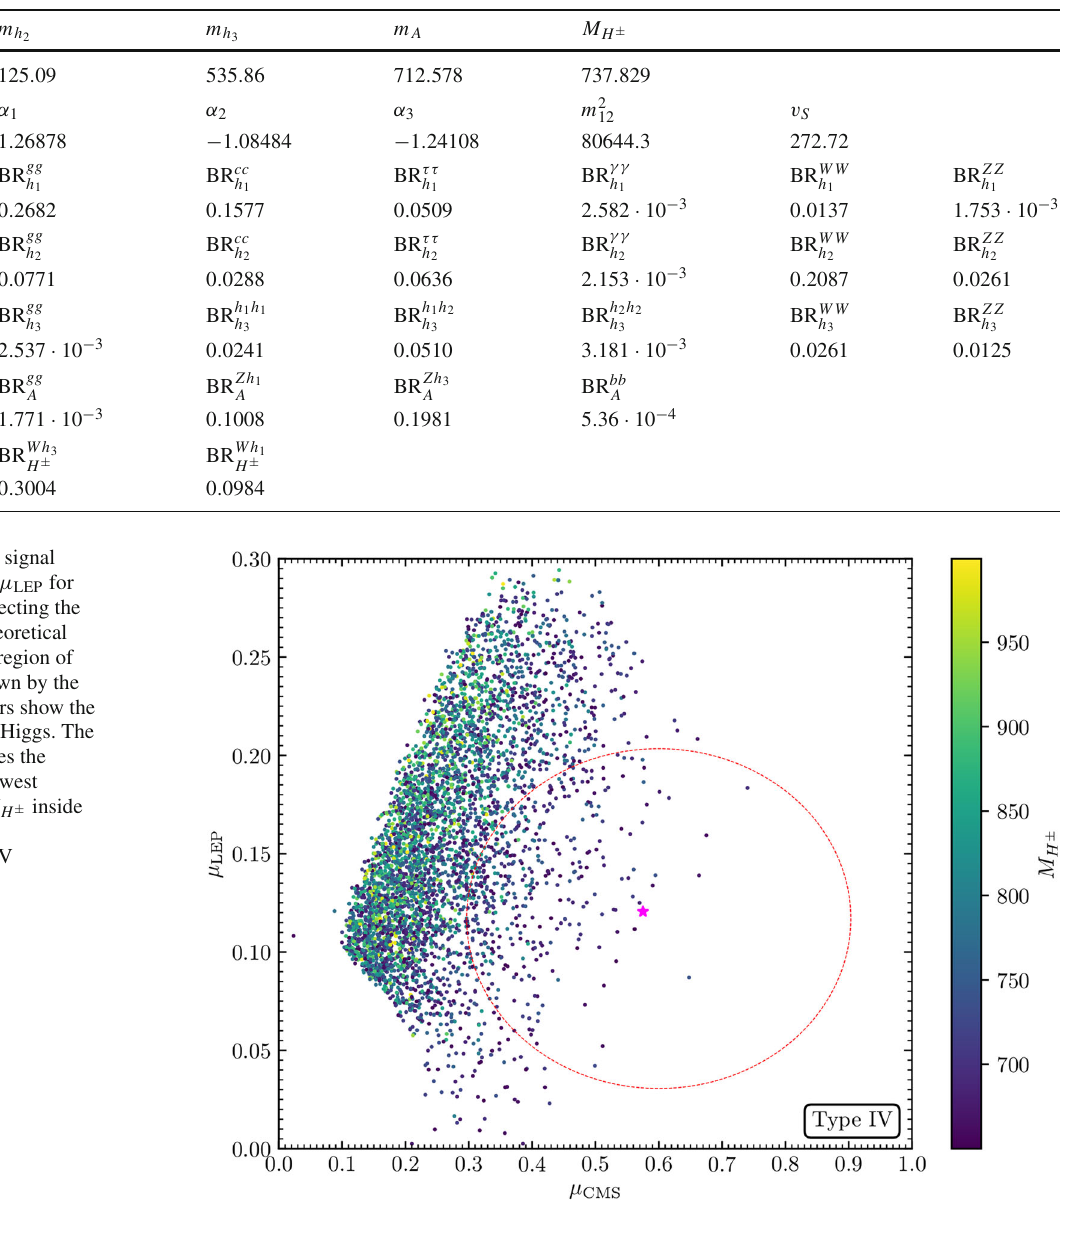
Table 5 Parameters of the best-fit point and branching ratios of the scalars in the type II scenario. Dimensionful parameters are given in GeV and the angles are given in radian